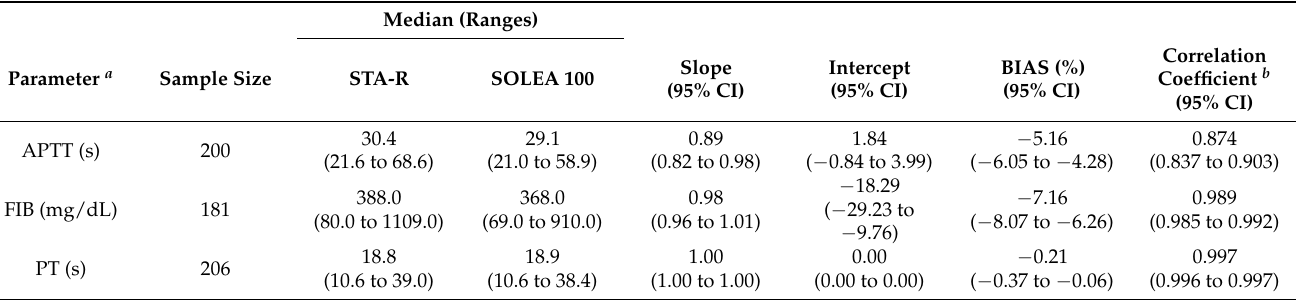
Table 1. Comparison among methods for activated partial thromboplastin time, fibrinogen, and prothrombin